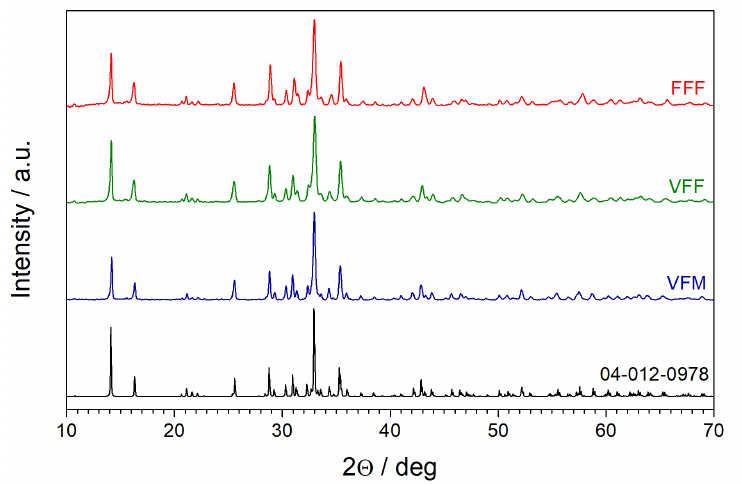
Figure 1. XRD patterns of nanocrystallized alluaudite-like glasses. A reference pattern of Na 2 Fe 2 Mn(PO 4 ) 3 alluaudite (ICDD Card No. 04-012-0978) is given at the